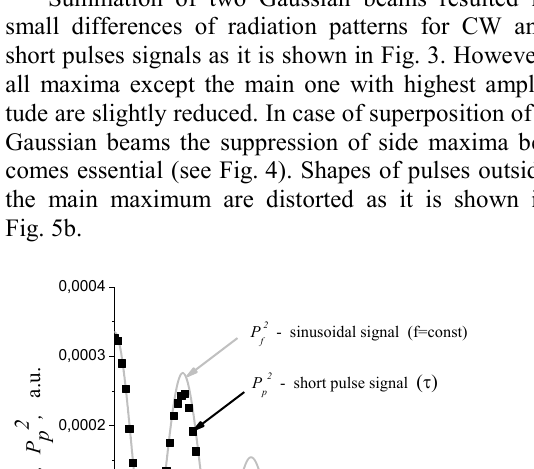
Fig. 2. Short pulse with the central frequency  (as an example) and Gaussian envelope.